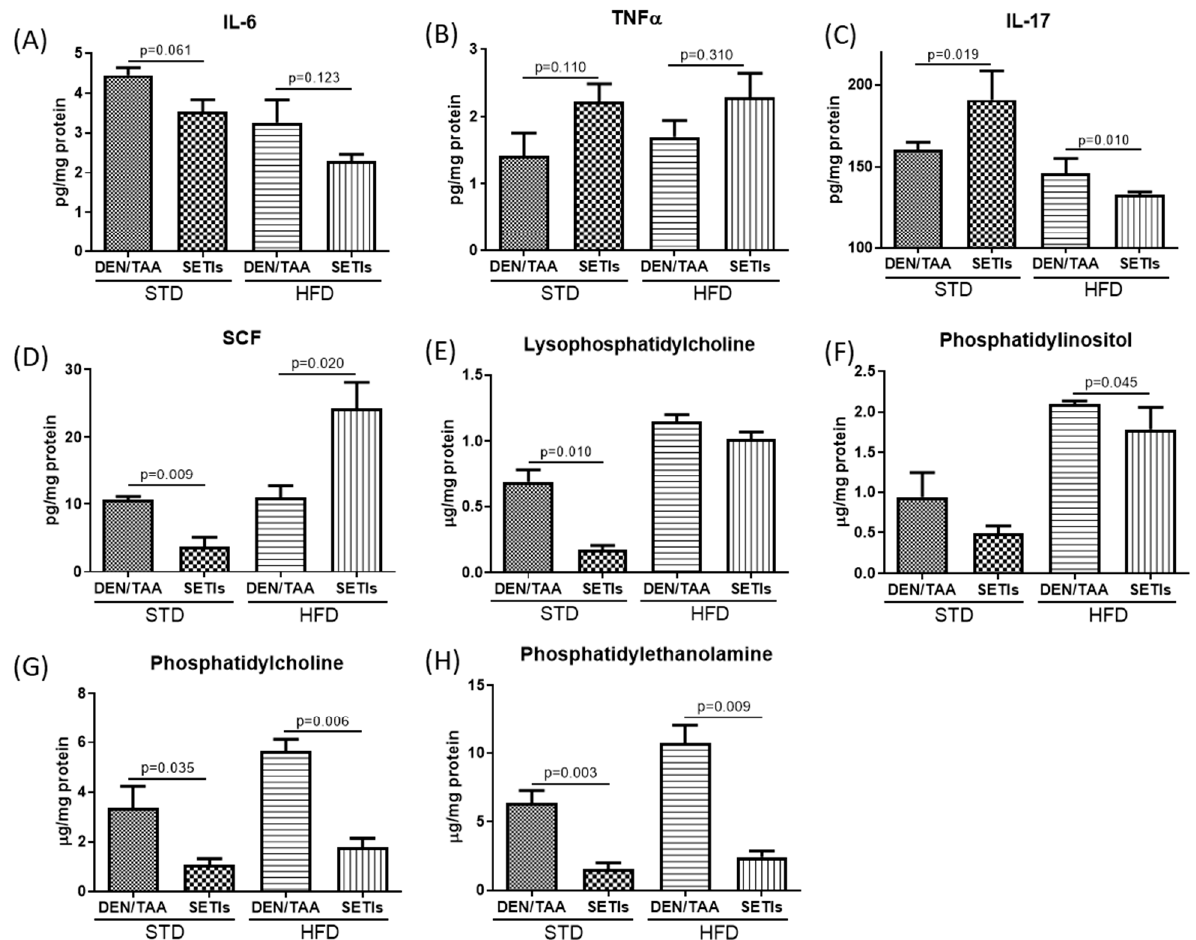
Figure 3. Hepatic concentration of immunological mediators in diethylnitrosamine (DEN)/thioacetamide (TAA)-treated mouse livers at 7 weeks, receiving or not receiving serine-type protease inhibitors (SETIs). Tissue cytokine concentration: ( A ) interleukin 6; ( B ) interleukin 17; ( C ) tumor necrosis factor (TNF)- α ; ( D ) stem cell factor (SCF); and phospholipids ( E ) lysophosphatydilcholine—LPC, ( F ) phosphatidylinositol—PI, ( G ) phosphatidylcholine—PC, and ( H ) phosphatidylethanolamine—PE. Results are expressed as mean ± mean standard error (SEM) ( n = 4 for panels ( A – D ); n = 6 for panels ( E – H )).